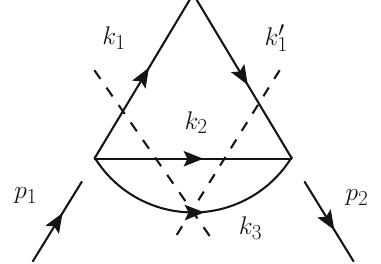
Fig. 1 Cutting rules for the spectral density of the double dispersion relation in Eq. (20)